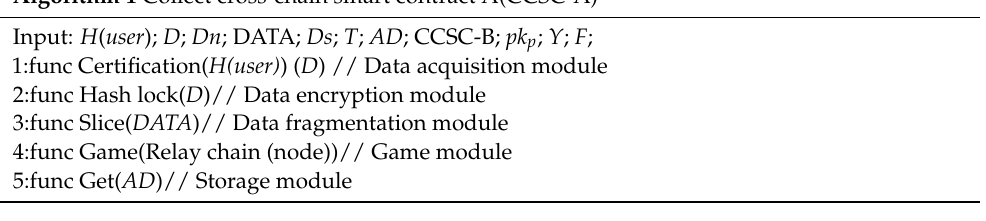
Algorithm 1 Collect cross-chain smart contract A(CCSC-A)